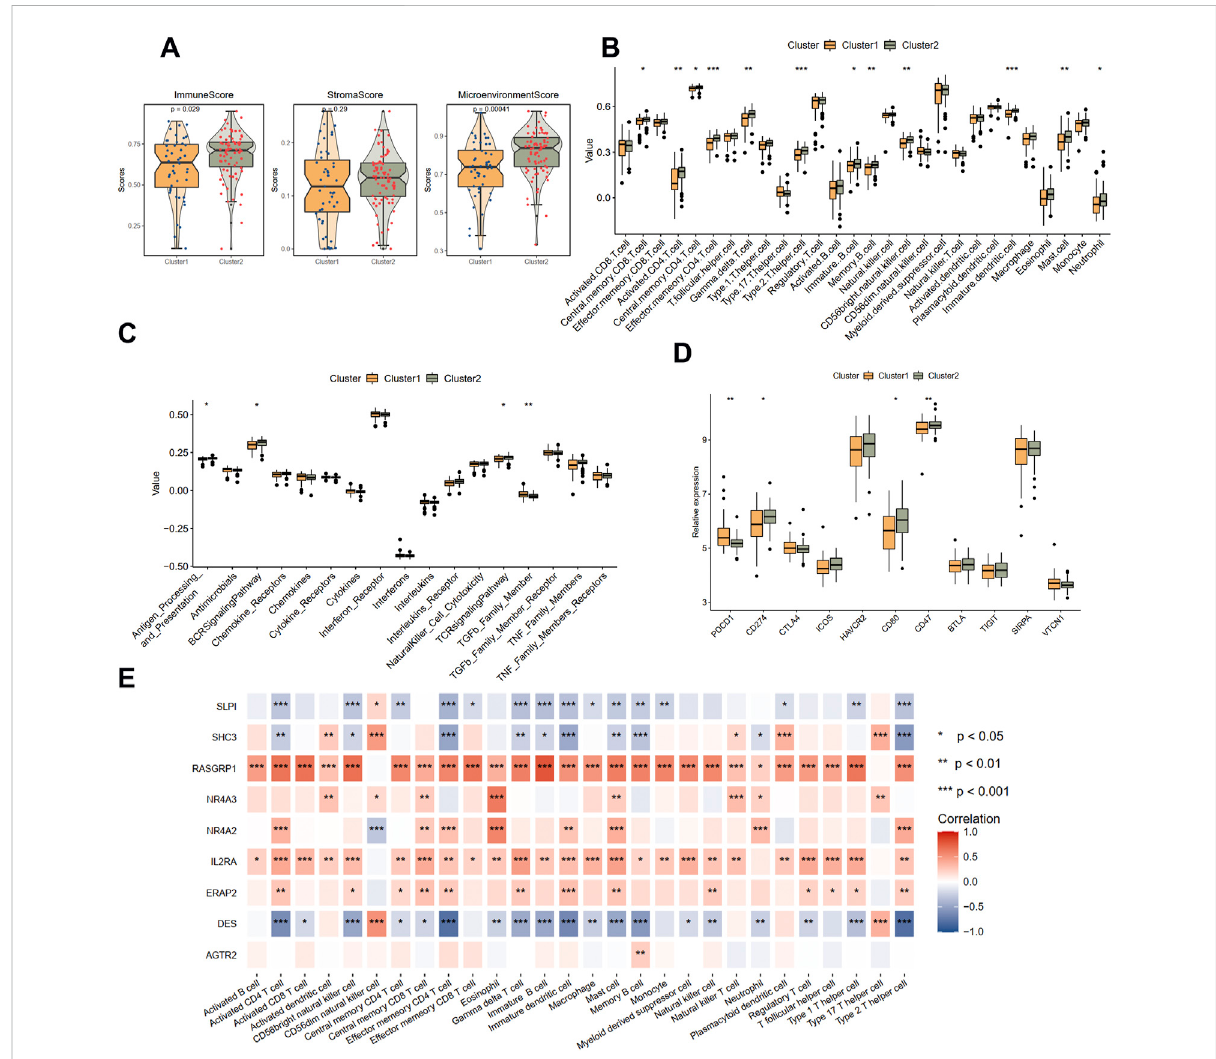
FIGURE 4 Immune landscapes between two different immune-related clusters. (A) The comparison of the immune score, stromal score, and microenvironment score in two clusters with xCell analysis. (B) The comparison of 28 immune cells in two clusters with ssGSEA analysis. (C) The comparison of17 immune responses in twoclusters with ssGSEA analysis. (D) The expression levels ofimmunecheckpointgenes in two clusters. (E) The correlations between immune cells and nine immune-related genes. Signi fi cance level was denoted by * p value < 0.05, ** p value < 0.01, *** p value <